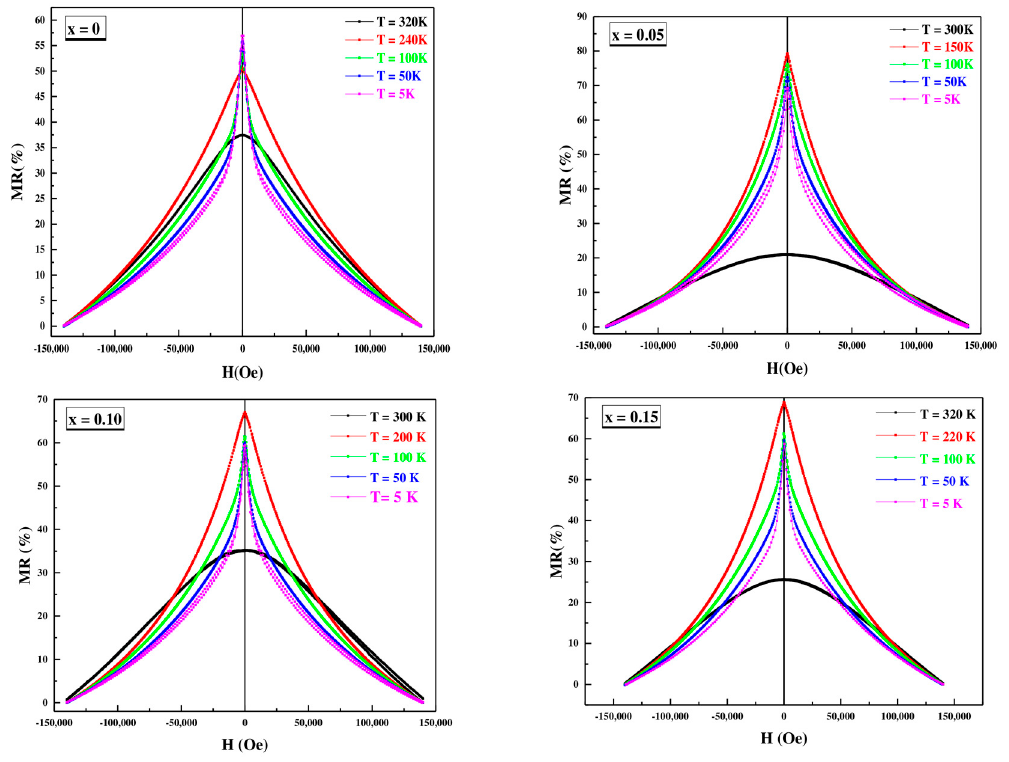
Figure 11. Magnetoresistance (%MR) vs. applied field at different temperature for 𝐏𝐫 𝟎.𝟕 𝐒𝐫 𝟎.𝟑 𝐌𝐧 (𝟏(cid:2879)𝐱) 𝐂𝐨 𝐱 𝐎 𝟑 nanopowders.